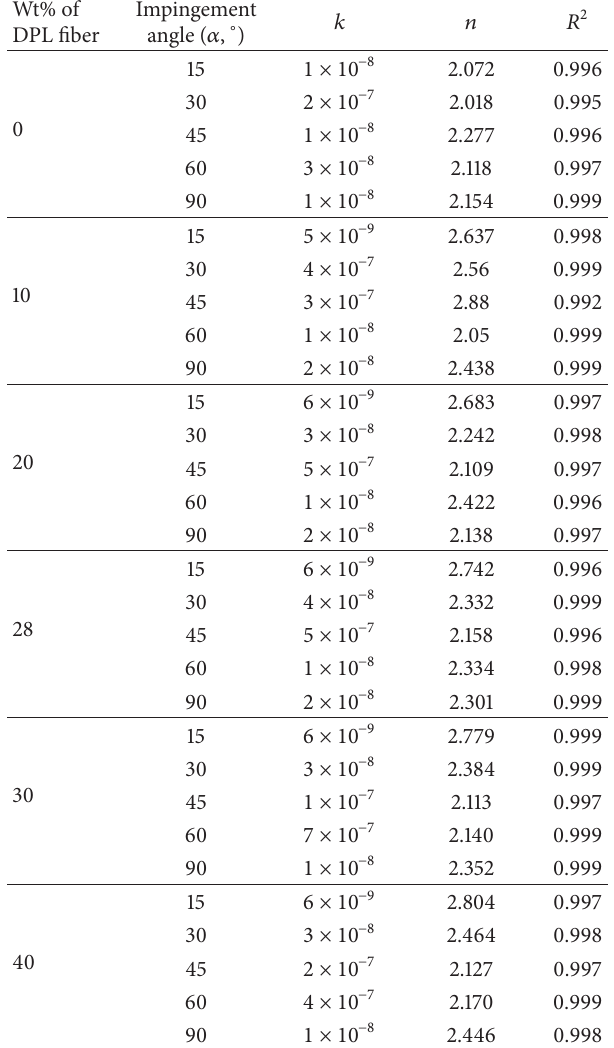
Table 2: Parameters characterizing the velocity dependence of erosion rate of PVA/DPL composites.